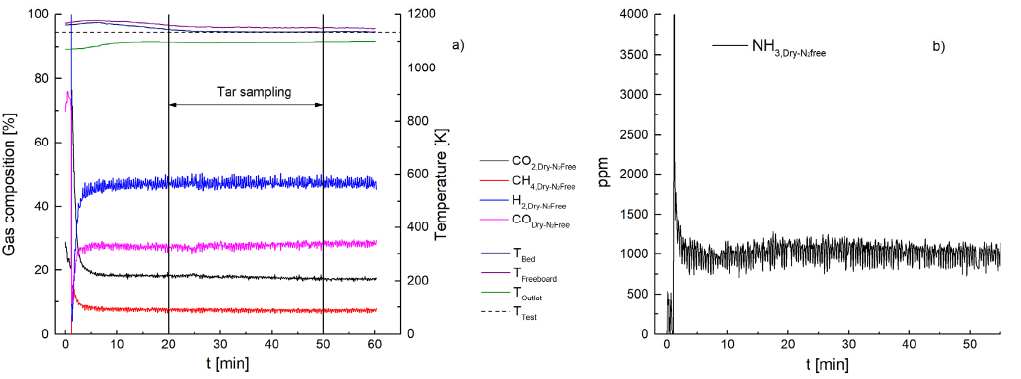
Figure 3. Temperature and gas composition ( a ) and ammonia content ( b ) during test 5.